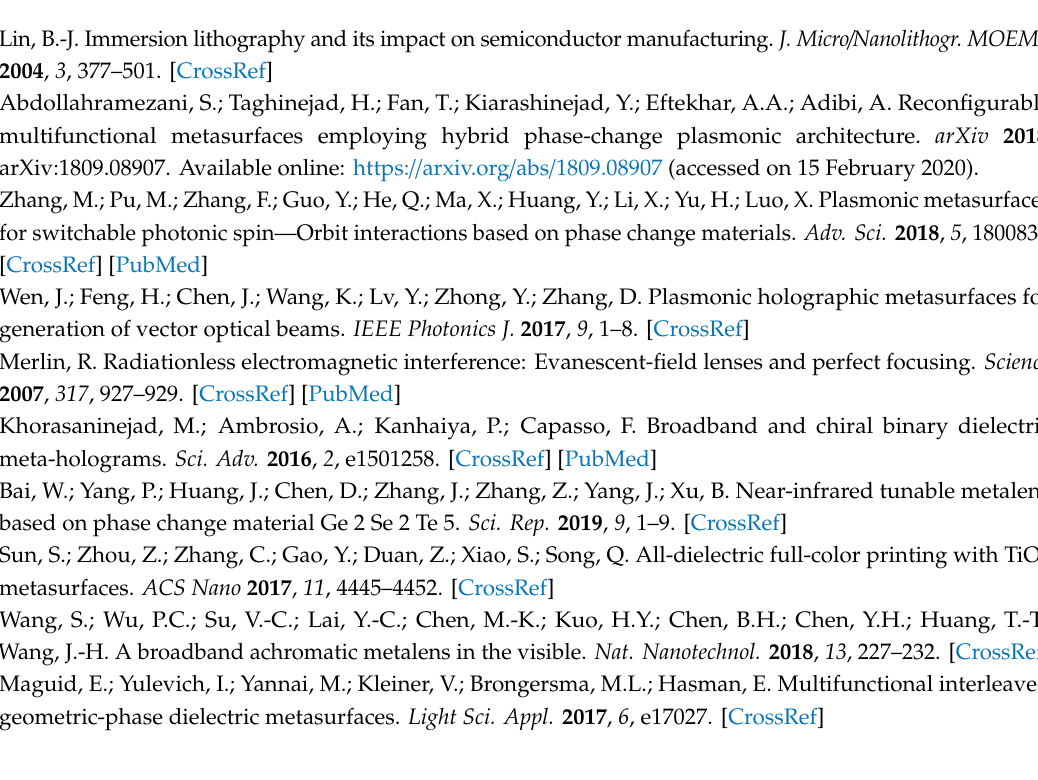
Figure S1: The real and imaginary part of the refractive index of Si 3 N 4 utilized in this study, displaying a high refractive index ( n > 2) and exceptionally low loss ( k = 0) over a broad UV